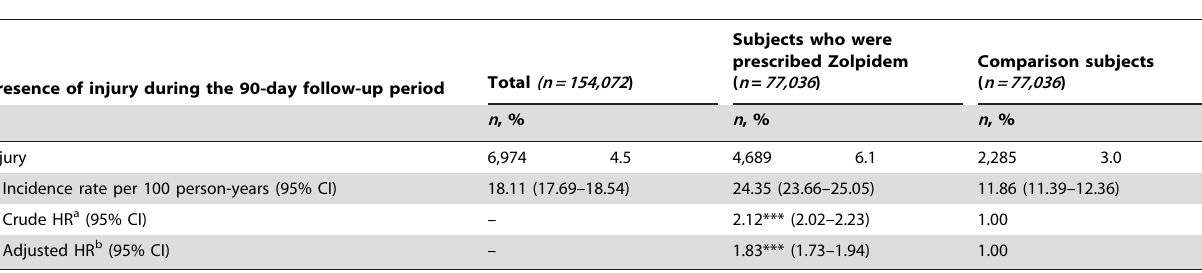
Table 2. Incidence rate, crude and adjusted hazard ratios for injury among the sampled subjects.